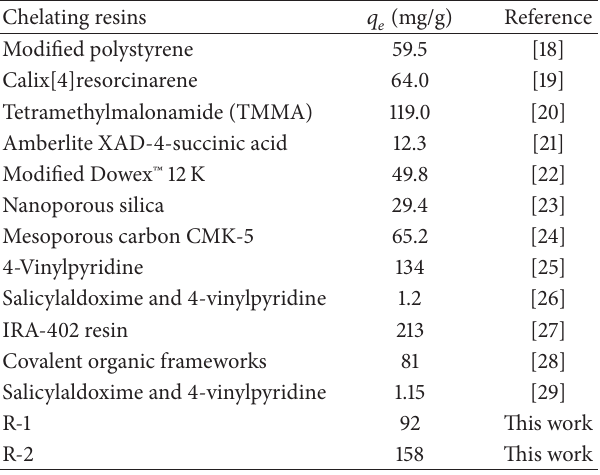
Table 1: Adsorption capacities of uranium by different